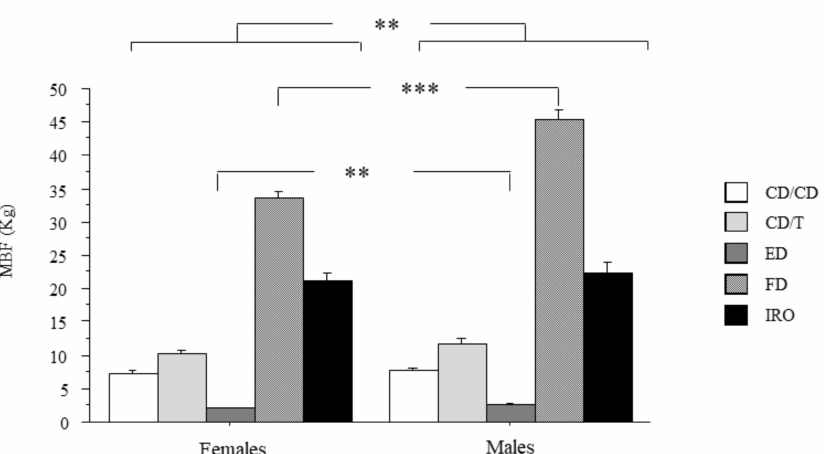
Figure 1. Bite force and gender. Maximal bite force according to gender. MBF: maximal bite force; subjects with natural full dentition (FD); subjects wearing implant-retained overdentures (IRO); subjects with natural teeth in one arch and wearing traditional complete dentures (CD) in opposite dental arch (CD/T); subjects wearing CD in both arches (CD/CD); edentulous patients in both arches (ED). Data are the mean ± SEM. Asterisk (*) indicates significant difference between the groups. ** p < 0.01; *** p < 0.001.